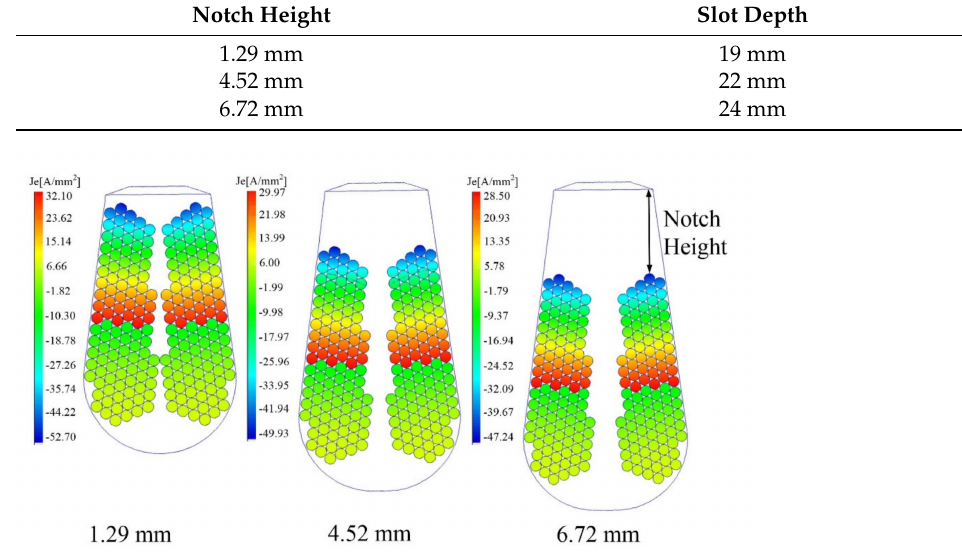
Table 3. Slot data in different cases.